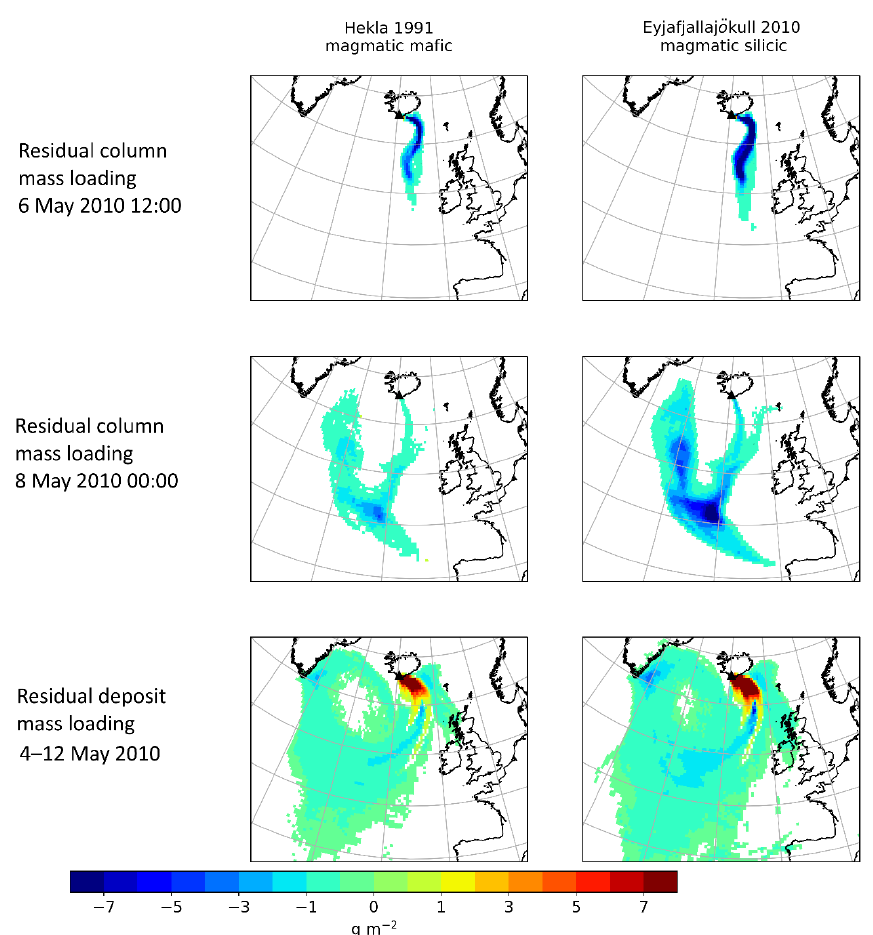
Figure 11. Residual mass loadings derived by subtracting the modelled mass loading using the VAAC default PSD from the result with either the coarse (Hekla 1991; left) or fine (Eyjafjallajökull 2010; right) PSD. The top two rows are residual total column mass loadings (in the air) on 6 May 2010 12:00 UTC and 8 May 2010 00:00 UTC (see Figure 10 for equivalent non-residual maps); the bottom row is residual deposit mass loadings (on the ground) for the period 4 – 12 May 2010 (see Figure 12 for equivalent non-residual maps).